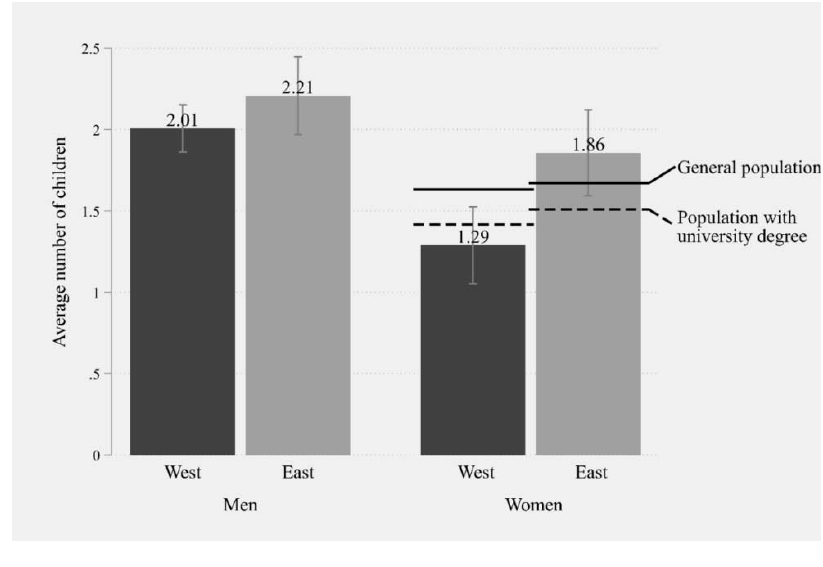
Figure 1 : Average number of politicians’ children by gender and region, and compared to the general population. 95%-confidence intervals